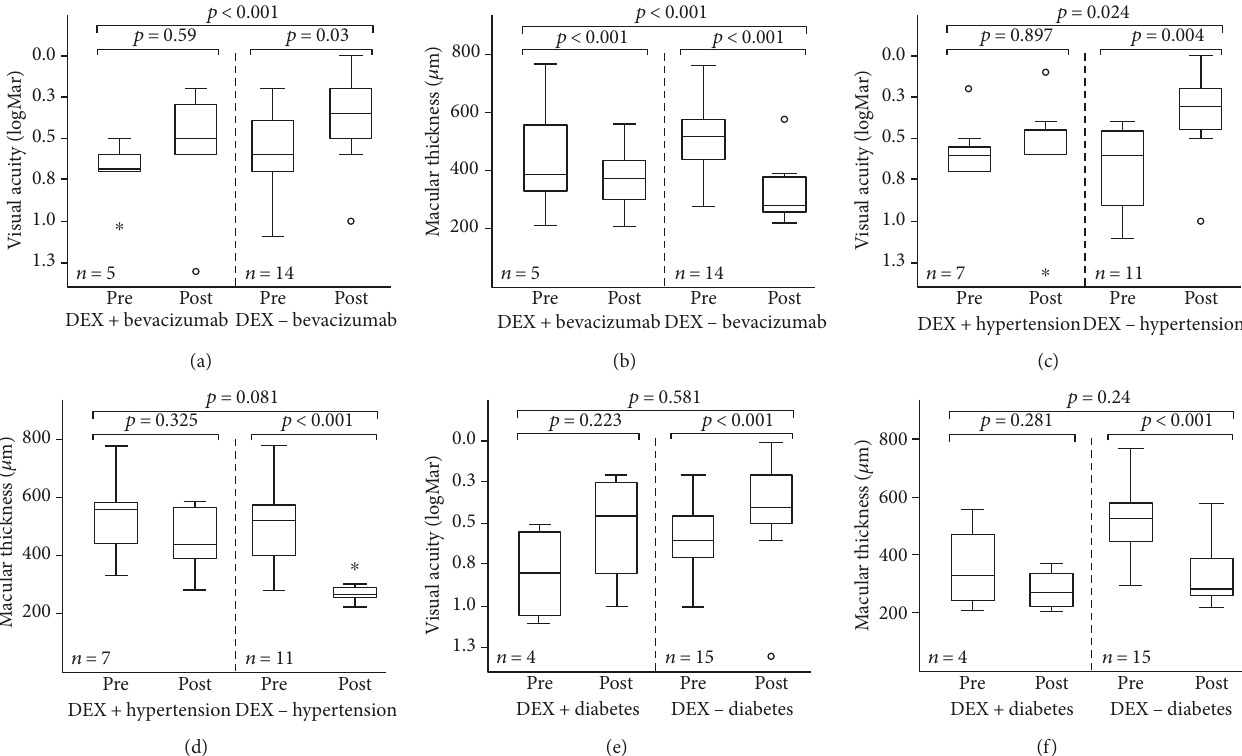
Figure 3: Visual acuity gain and macular thickness decrease comparison between DEX implantation therapy and combined DEX implantation and intravitreal bevacizumab therapy in PCME. (a) Visual acuity (logMAR) gain after DEX implant only compared to DEX implantation and bevacizumab injection is shown in this graphic. The box plot shows median visual acuity in logMAR (vertical line in the column), 95% con fi dence interval (column), and the standard deviation (extension lines) before and after treatment with DEX